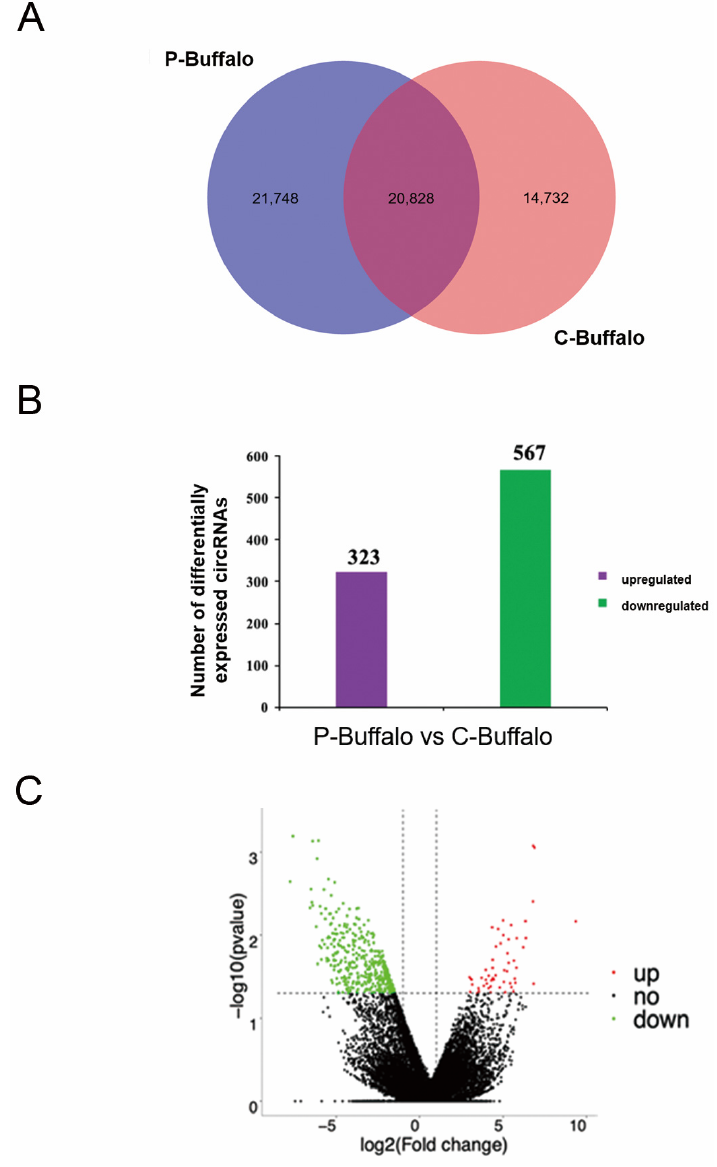
Figure 2. Identification of DECs in blood between C-Buffalo and P-Buffalo. ( A ) Venn diagram of circRNAs in P-Buffalo and C-Buffalo. Blood from C-Buffalo and P-Buffalo on day 25 after AI was subjected to RNA sequencing. The expression levels of circRNAs in the blood of buffaloes were analyzed by dichotomous statistical tests. Overlapping circles indicate circRNA, which was common in the blood of both groups of buffaloes. Circles that do not overlap indicate that circRNA is particular to (pink) non-pregnant buffalo and (blue) post-pregnant buffalo. ( B ) Amount of DECs in P-Buffalo and C-Buffalo. Adjusted results for p < 0.05 and |log2-fold change| ≥ 1 were considered statistically significant. Purple bar denotes up-regulated circRNAs; green indicates down-regulated circRNAs. ( C ) Volcano plot showing differences in circRNAs between P-Buffalo and C-Buffalo. Volcano map depicting differential expression between C-Buffalo and P-Buffalo. Differential expression of genes. Red shows up-regulated DECs, green depicts down-regulated DECs, and black diamond has no significant difference.